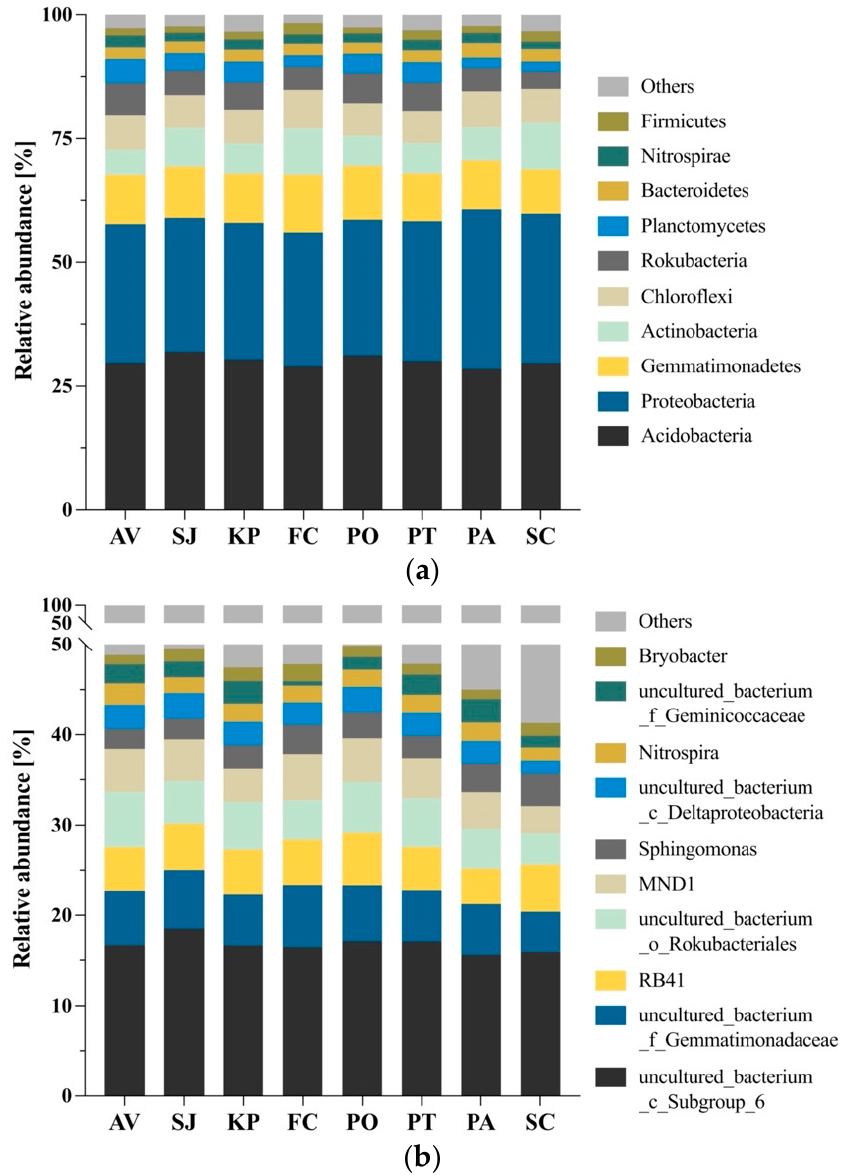
Figure 3. Rhizosphere bacterial abundance in different stands: ( a ) at the phylum level; ( b ) at the genus level. (AV, A. vulgaris ; SJ, S. japonica ; KP, K. paniculata ; FC, F. chinensis ; PO, P. orientalis ; PT, P. tabuliformis ; PA, P. asperata ; SC, S. chinensis. )